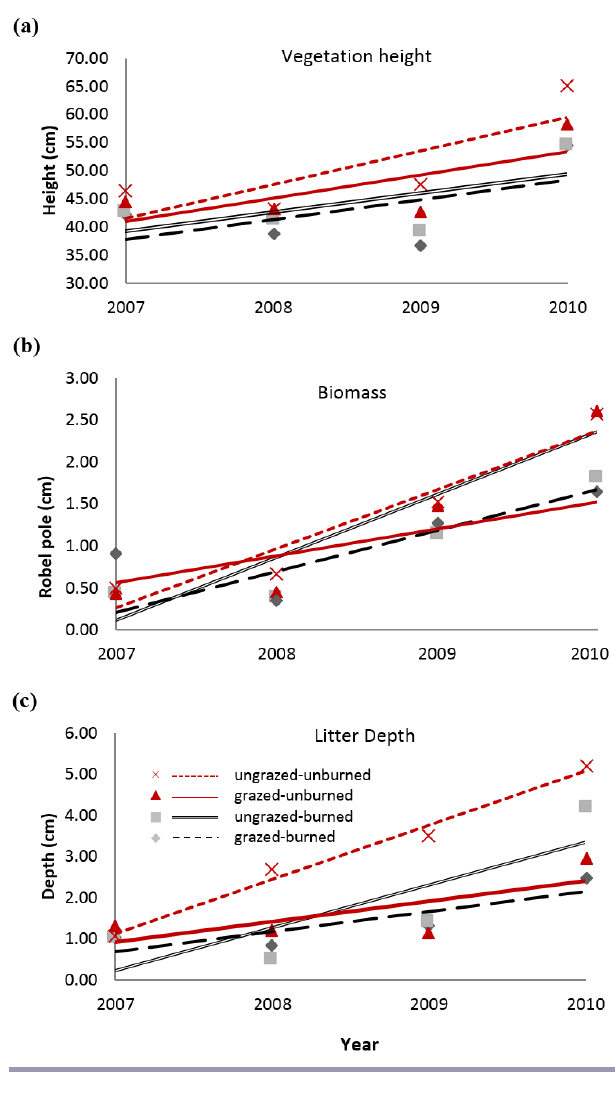
Fig. 3 . Habitat structure per plot (3.2 ha) for (a) vegetation height, (b) vegetation biomass, and (c) litter depth in burned- grazed (long dashed line), burned-ungrazed (double line), unburned-grazed (solid line), and unburned-ungrazed (short dashed line) sites in Grasslands National Park of Canada and Mankota Community Pastures, southern Saskatchewan, 2007 to 2010. Burned trends are shown in black, unburned trends in red. Only the mean value for the data from each treatment per year is shown, to simplify the graphs and facilitate